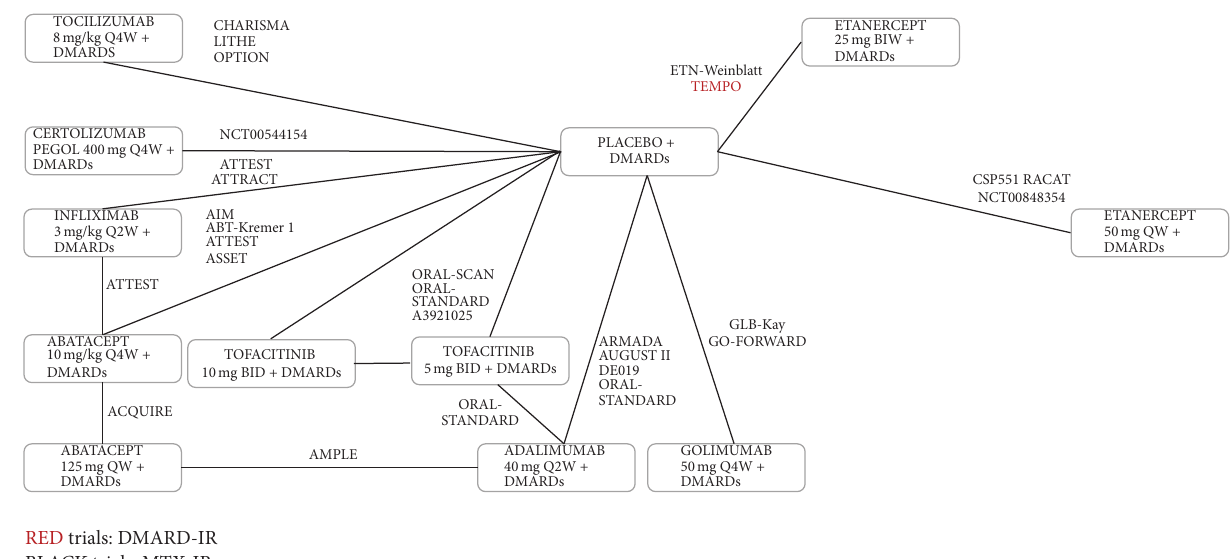
Figure 4: MTX combination therapy evidence